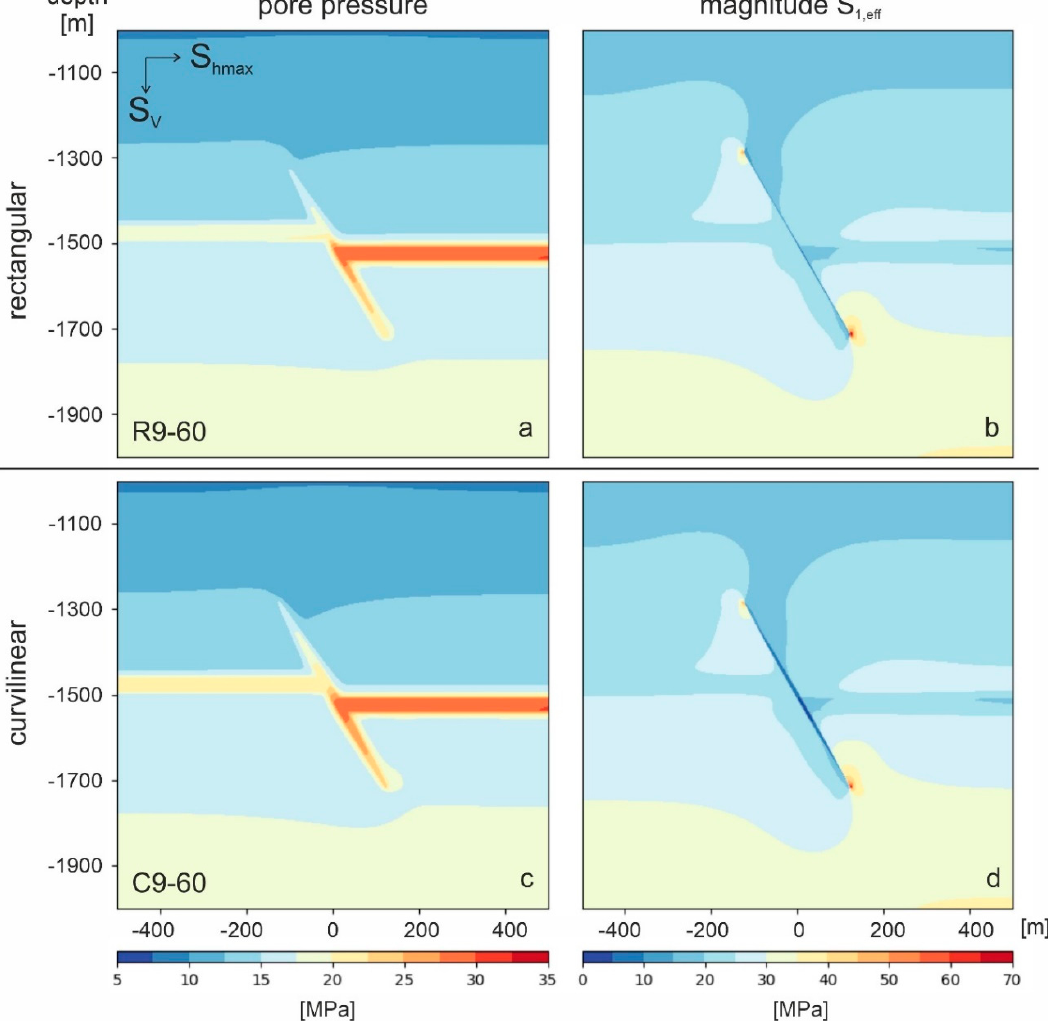
Figure 10. Results after the last load step for a 9-element wide fault zone with 60° dip embedded with different grids. Rectangular grid: ( a ) spatial variations in the pore pressure ( b ) magnitude of the effective maximum principal stress (S 1,eff ). Curvilinear grid: ( c ) spatial variations in the pore pressure ( d ) magnitude of S 1,eff .